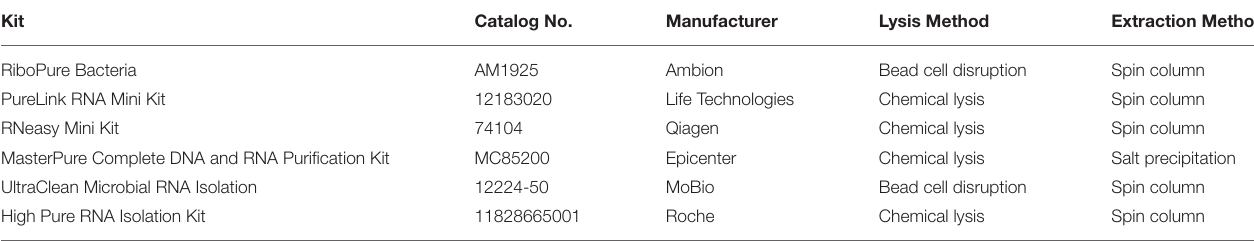
TABLE 2 | Commercial RNA extraction kits.